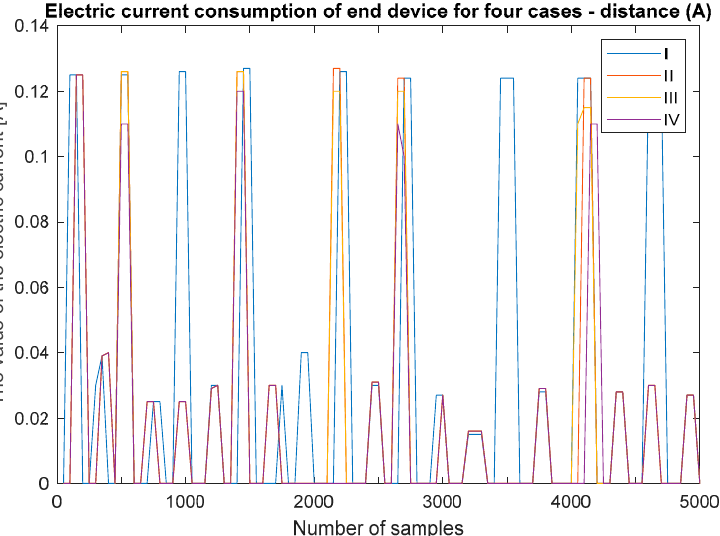
Figure 15. Graph of electric current consumption of the end device for four cases and devices— locations (A).